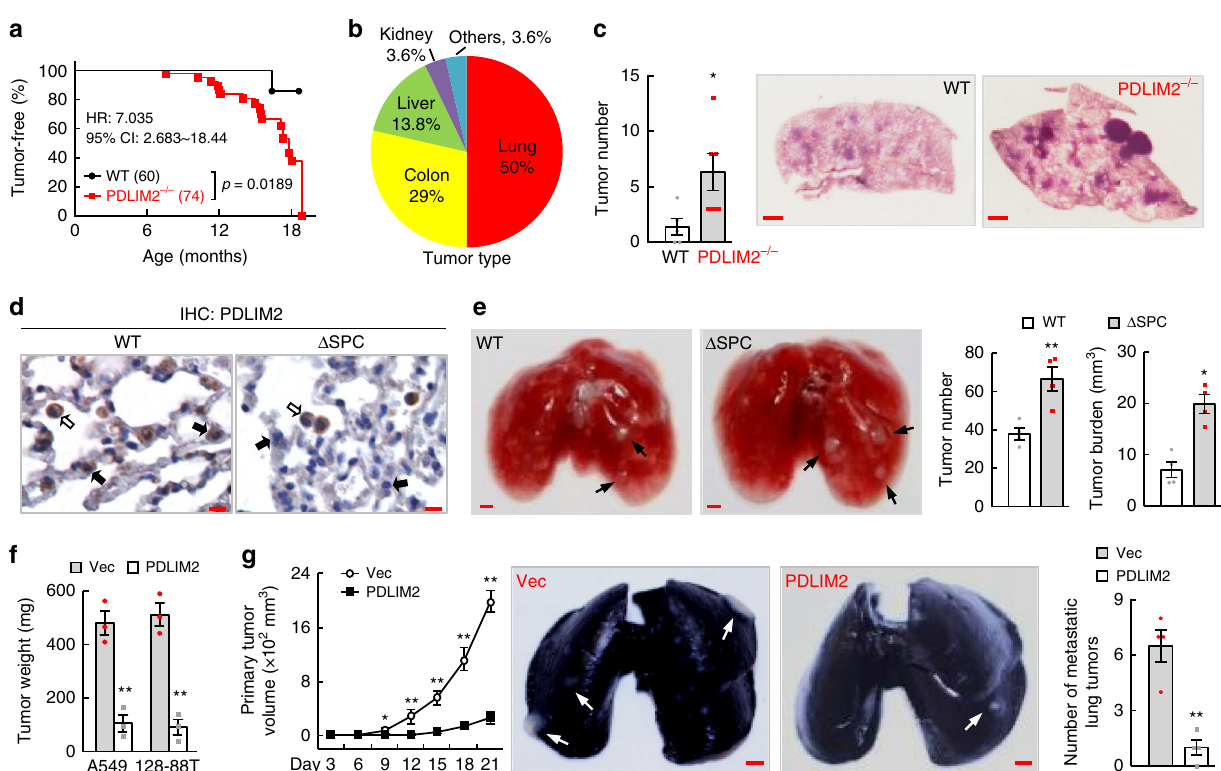
Fig. 3 PDLIM2 loss increases tumorigenesis while its reconstitution suppresses lung cancer development and metastasis. a Kaplan – Meier tumor-free survival curve showing increased spontaneous tumors in PDLIM2 − / − mice compared to wild-type (WT) mice. Log-rank test was performed. b Percentile of tumor types spontaneously developed in PDLIM2 − / − mice showing a majority of lung tumors. c K-Ras G12D model showing increased lung tumors in PDLIM2 − / − mice (WT: n = 5, PDLIM2 − / − : n = 6). Scale bar, 1 mm. d Lung tissue IHC analysis showing speci fi c deletion of PDLIM2 from lung epithelial cells in Δ SPC mice treated with urethane. Lung epithelial and myeloid cells are indicated by black and white arrows, respectively. Scale bar, 10 μ m. e Urethane model showing increased lung tumors in Δ SPC mice ( n = 4). Scale bar, 1 mm. f SCID mouse model showing lung tumor suppression by PDLIM2 reconstitution ( n = 3). g MAD109 syngeneic model showing PDLIM2 suppression of primary and metastatic lung tumors ( n = 4). Scale bar, 1 mm. Student ’ s t test (two tailed, unpaired) was performed, and data represent means ± SEM in ( c , e – g ). * P < 0.05; ** P <